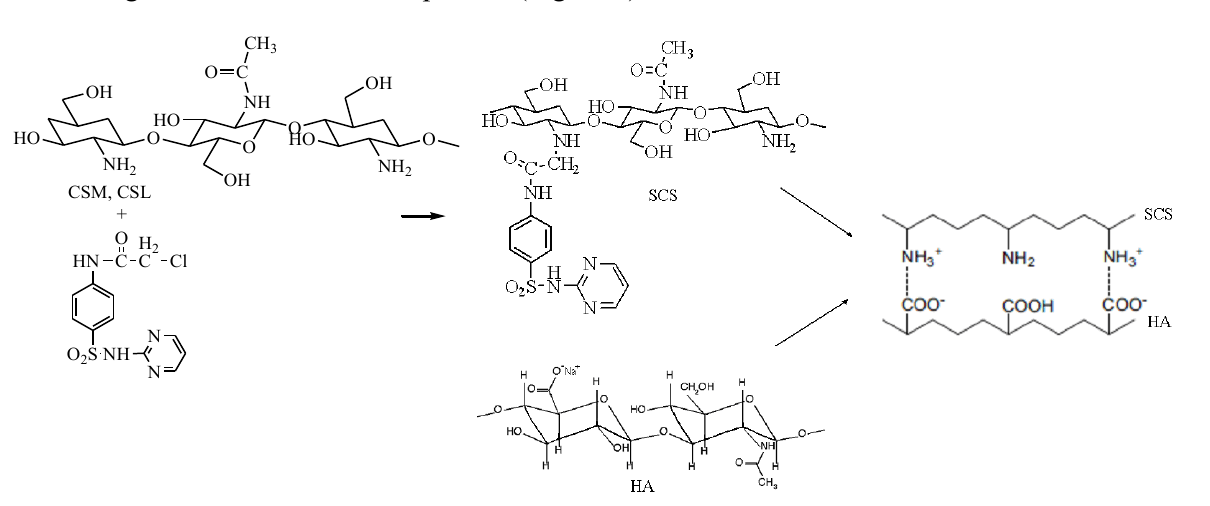
Figure 1. Formation of polyelectrolyte complexes (PECs) with sulfadiazine-chitosan conjugate (SCS) and sodium hyaluronate